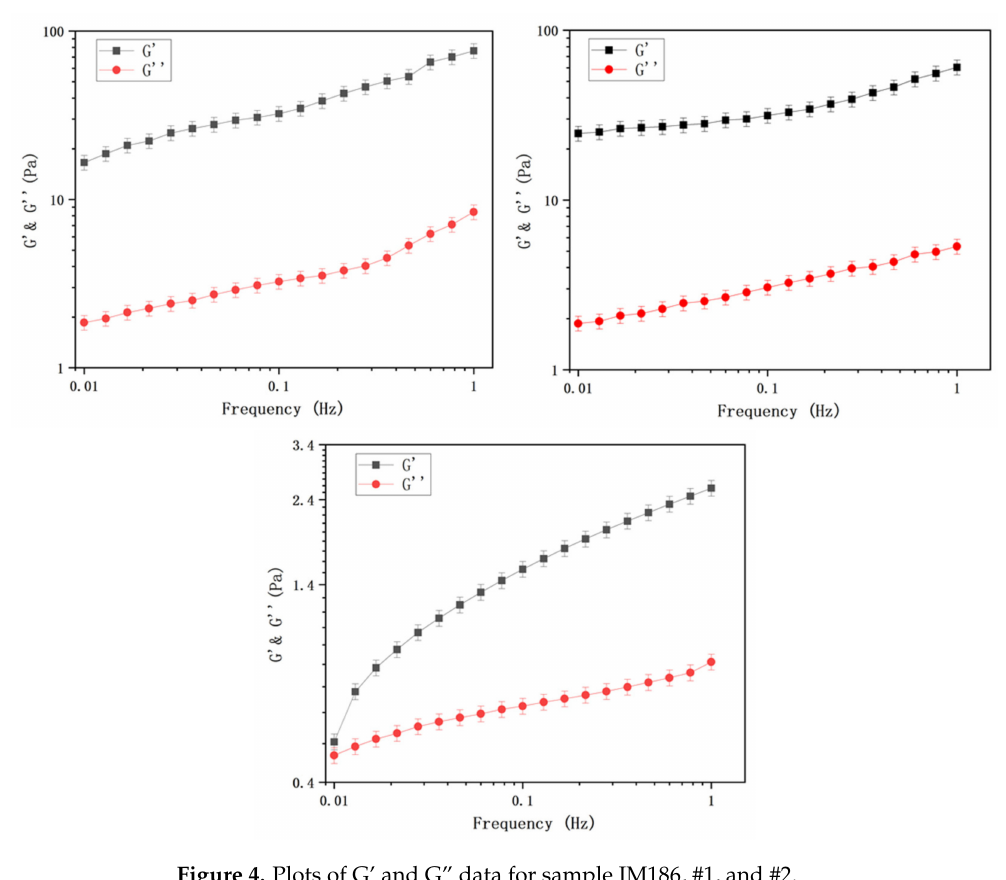
Figure 4. Plots of G’ and G” data for sample JM186, #1, and #2.